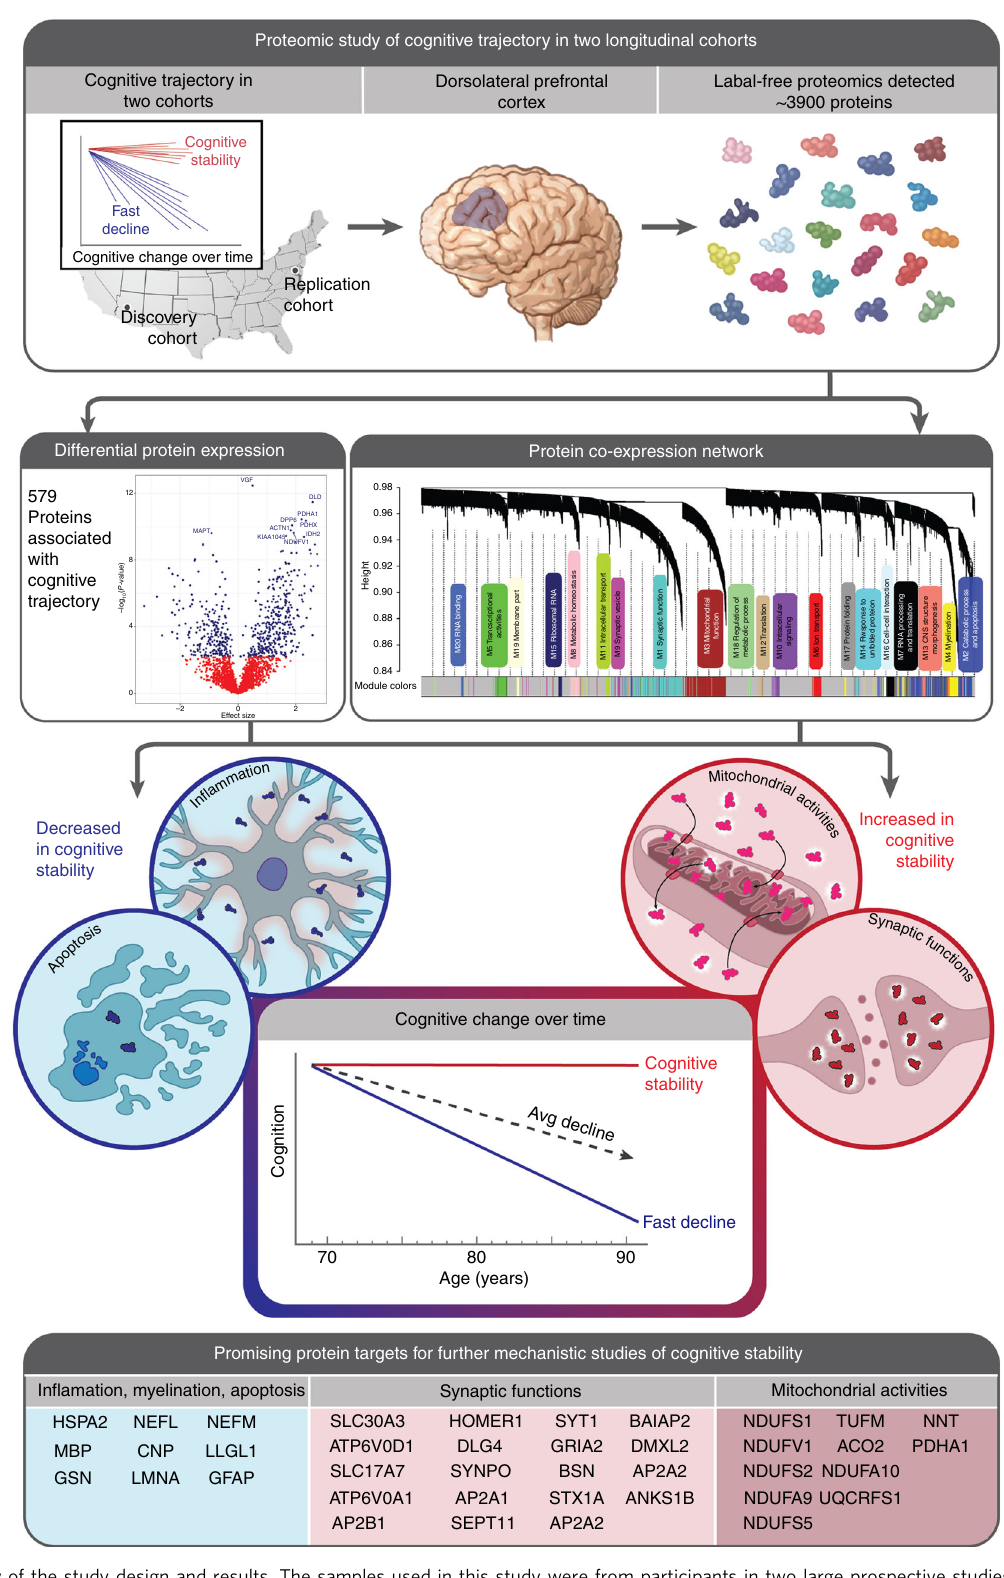
Fig. 1 Overview of the study design and results. The samples used in this study were from participants in two large prospective studies of aging in the United States who donated their brains upon death. Each subject in the present study were initially cognitively normal and had antecedent cognitive data used to estimate personal cognitive trajectories. Whole brain proteomic analysis of dorsolateral prefrontal cortex was used to estimate protein abundance for each participant. Proteome-wide association study of cognitive trajectory and protein co-expression network analysis revealed that individuals with cognitive stability (i.e., relatively little decline in cognition over time) have decreased abundance of the proteins involved in in fl ammation and apoptosis but increased abundance of the proteins involved in mitochondrial activities and synaptic function. Promising protein targets for further study are